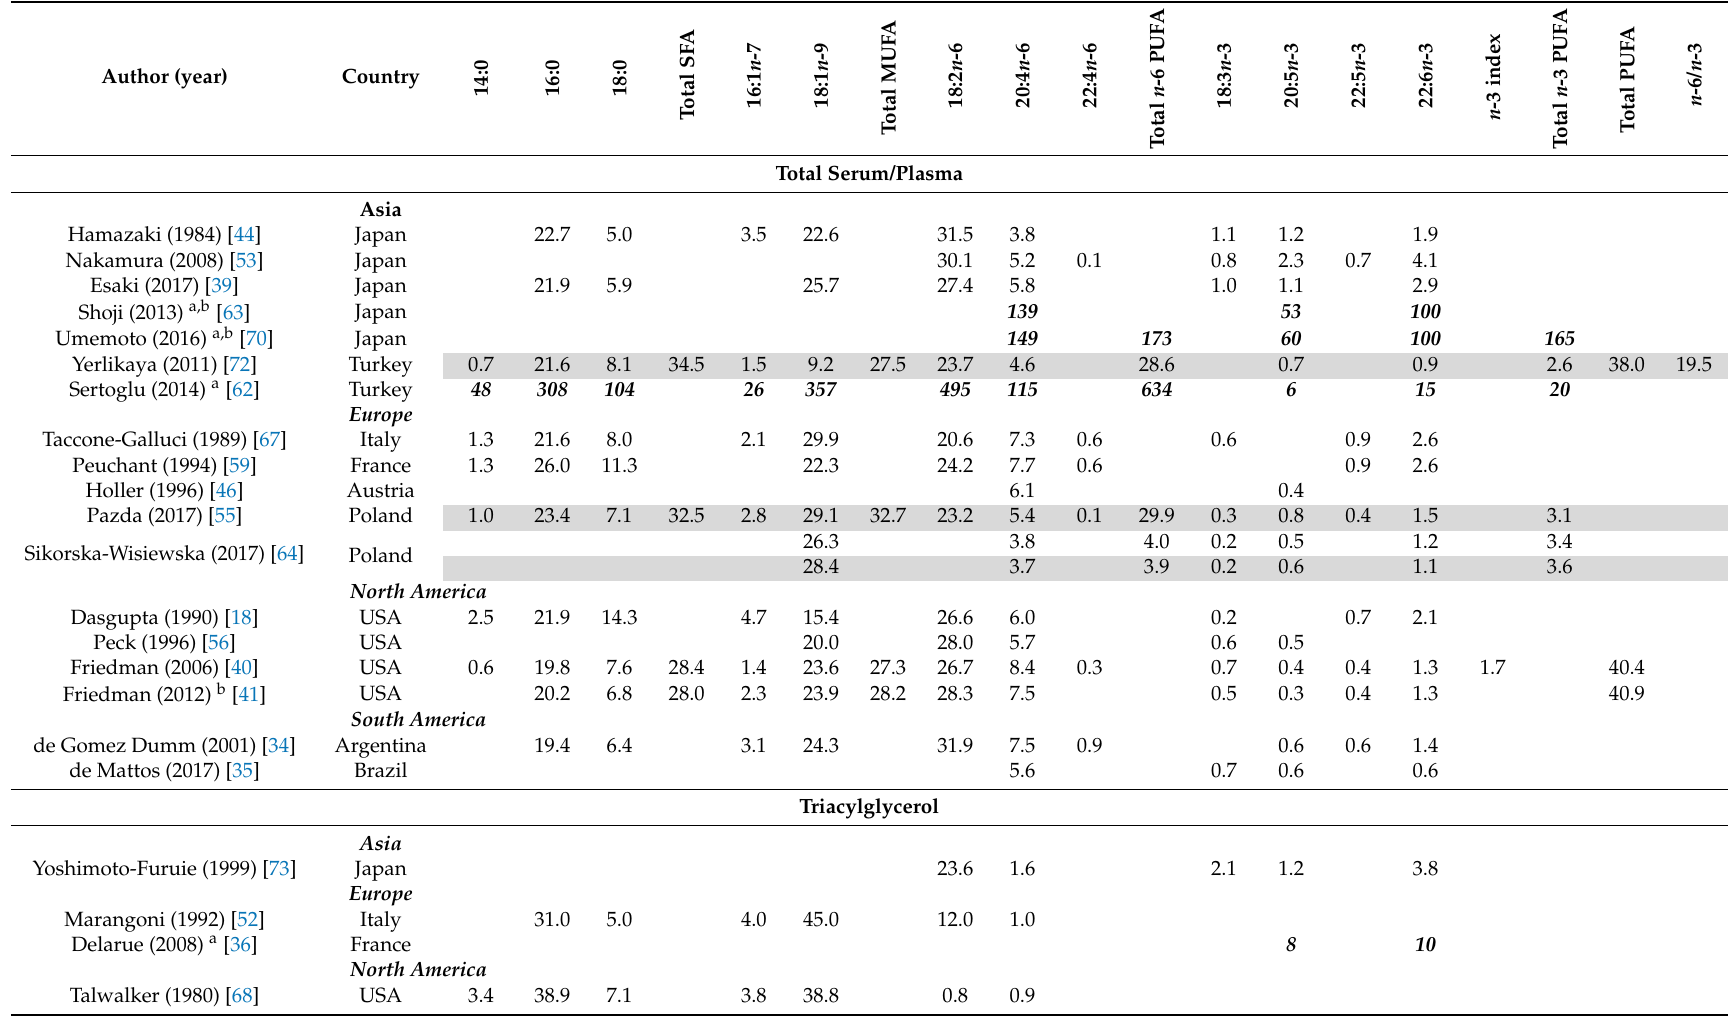
Table 2. Blood fatty acid profiles (relative percentage) of dialysis